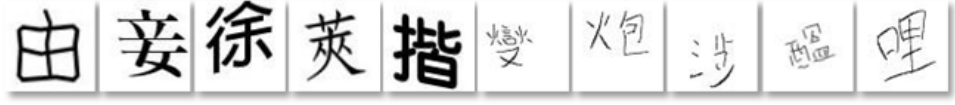
Figure 12. Some samples from our Chinese character dataset after data augmentation.